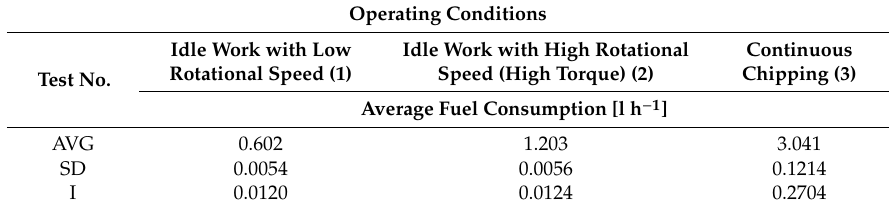
Table 2. Results of fuel consumption measurements of a cylindrical chipper powered by an internal